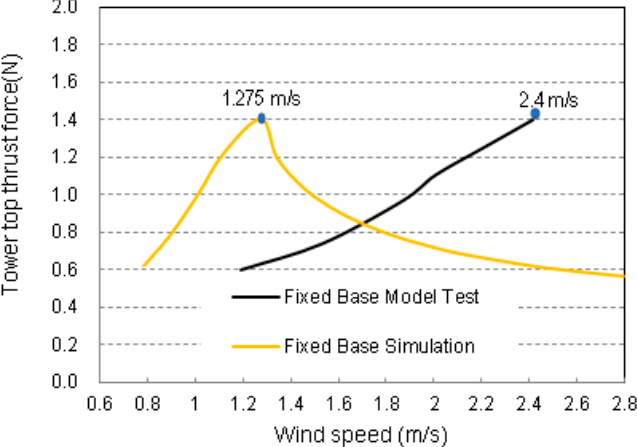
Figure 7. Comparison of the tower top thrust forces between fixed base model test and simulation (results are presented at a model scale ratio).